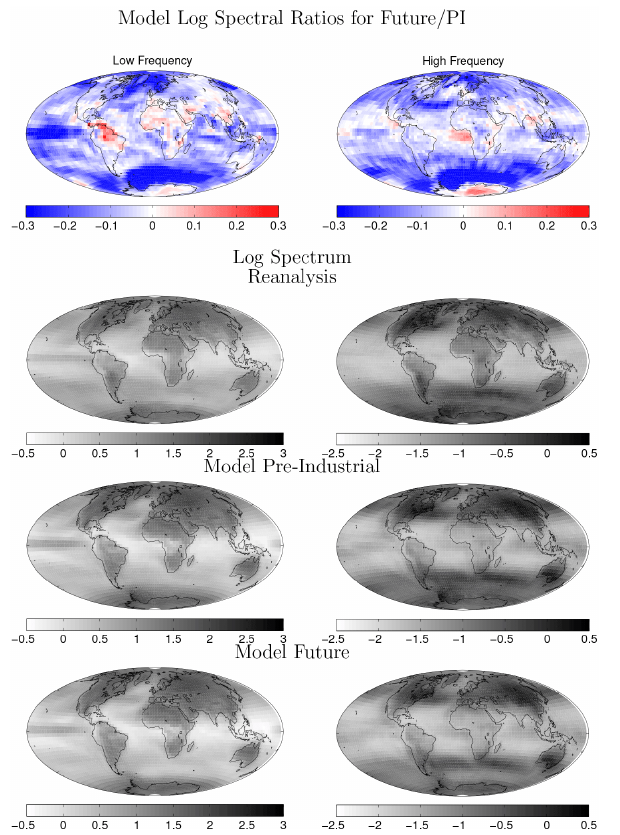
Figure 5. (Top) Estimated log (base 10) ratio of spectral densities for model scenario vs. baseline at low and high frequencies. The low-frequency results are the estimated log ratios at 1168 days and the high-frequency results at 2 days; however, due to the large de- gree of smoothing, it is best to think of them as representing low- and high-frequency behavior. Both long- (left column) and short- term (right column) variability decreases in nearly all locations. Re- mainder of rows: estimated log-spectral densities at these frequen- cies for reanalysis (second row), model baseline period (third row) and model scenario period (bottom row), using the demodulated and deseasonalized time series. The pattern of enhanced variability over land vs. ocean and high vs. low latitudes is as